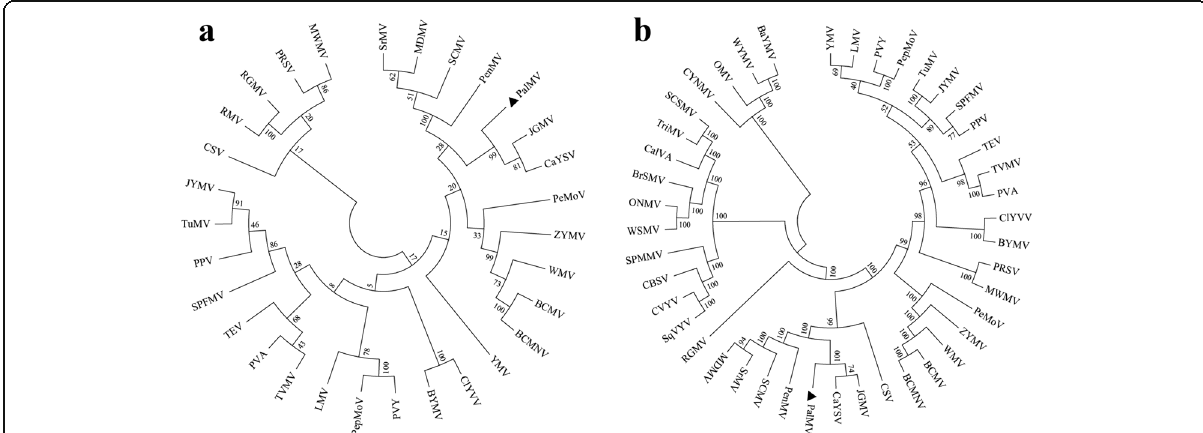
Fig. 4 Phylogenetic trees illustrating the position of PalMV among the members of the family Potyviridae . Phylogenetic analysis of the deduced aa sequences of polyprotein ( a ) and coat protein ( b ) of PalMV and other potyviruses. Sequence sources are listed in Additional file 2: Table S2. Phylogenetic tree was generated by neighbor-joining method with 1000 bootstraps replicates using MEGA7.0.2 software. The numbers at the nodes indicate the percentage of 1000 bootstraps occurred in this group. PalMV is highlighted by triangle in